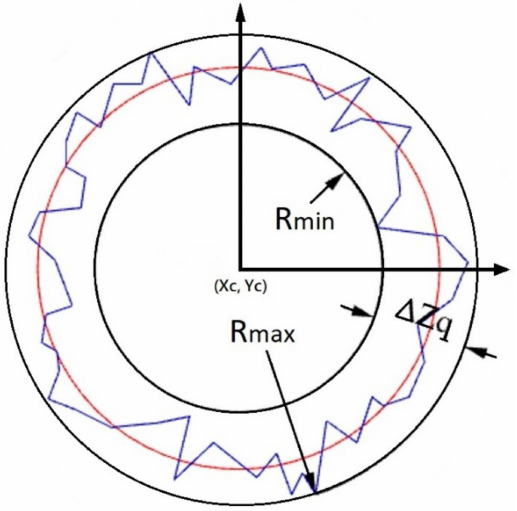
Figure 2. Least squares circle method for determination of roundness ( ∆ Zq ) at specified